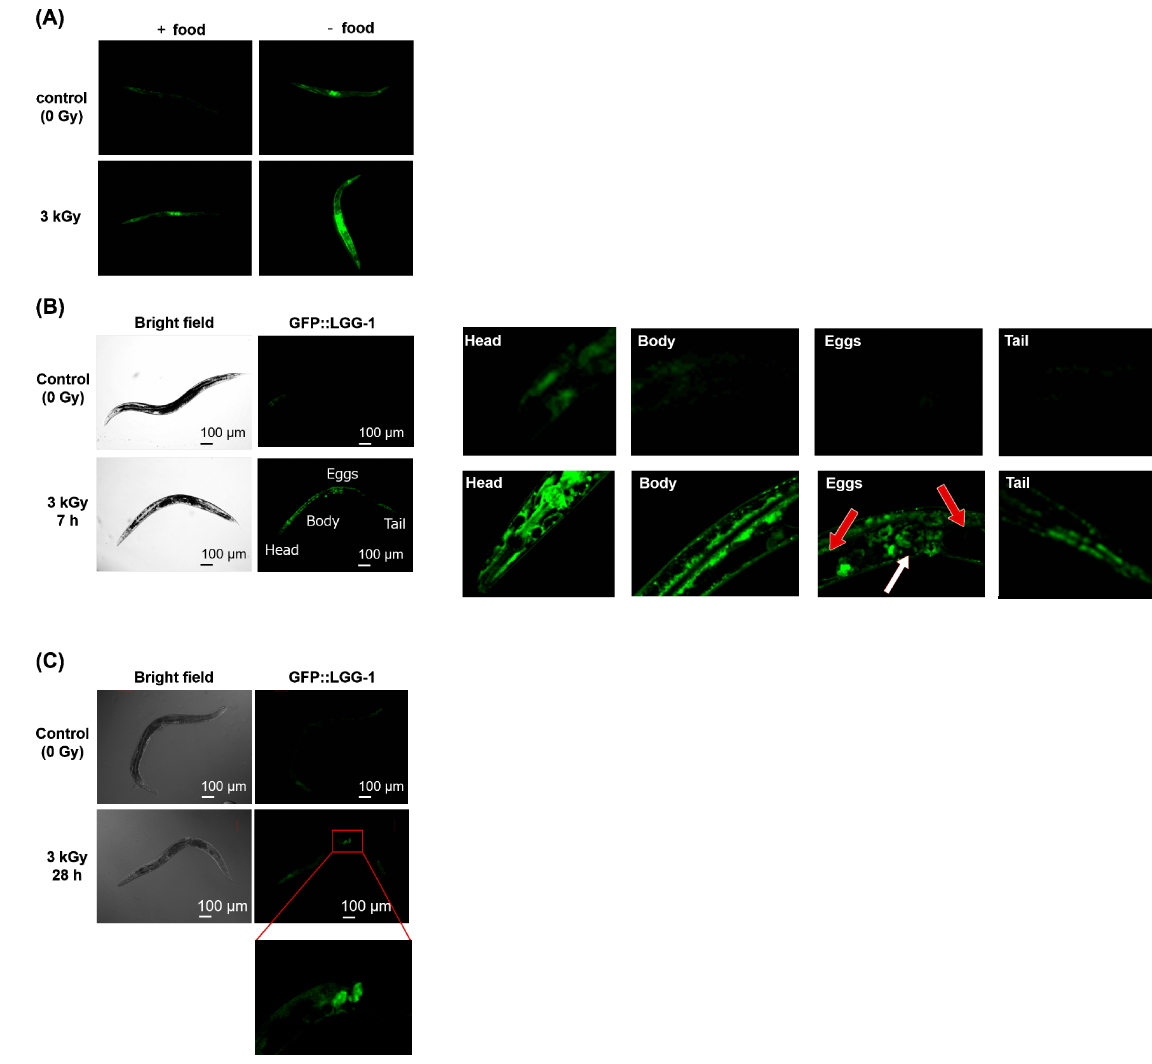
Figure 7. Detection of autophagy after whole-body γ -ray irradiation by GFP::LGG-1 assay. Well-fed adult DA2123 [ lgg- 1 p:: gfp :: lgg-1 + rol-6 ( su1006 )] C. elegans were irradiated with 3 kGy of γ -rays to the whole body. After incubation in the dark at 20 °C on NGM plates with a bacterial lawn, worms were paralyzed using sodium azide and mounted on an agar pad. Then, GFP fluorescence from the worms was observed by microscopy using a 488 nm argon laser. ( A ) Fluorescence in worms 12 h after γ -ray irradiation with or without food. ( B ) Fluorescence in worms 7 h after γ -ray irradiation. An irradiated worm was enlarged to show the head, anterior body, eggs, and tail. The white arrow indicates the vulva and red arrows indicate eggs. ( C ) Fluorescence in worms 28 h after γ -ray irradiation.